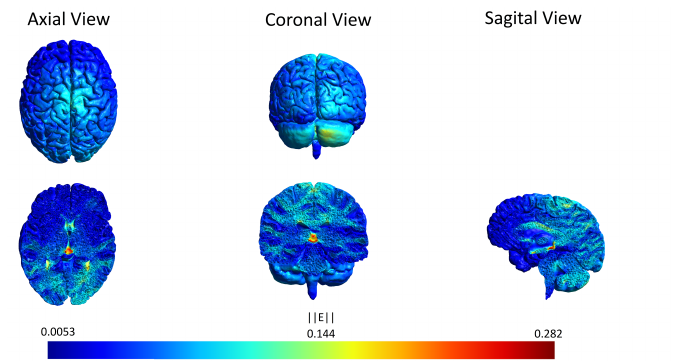
Figure 3. Axial, coronal and sagital view of the tDCS simulation. The scale represents the electric field (V/m) induced by the anode located over Cz and cathode over the right cerebro-cerebellum. The intensity applied was 0.4 mA. The most affected area (red) is close to the red nucleus. The image was generated with